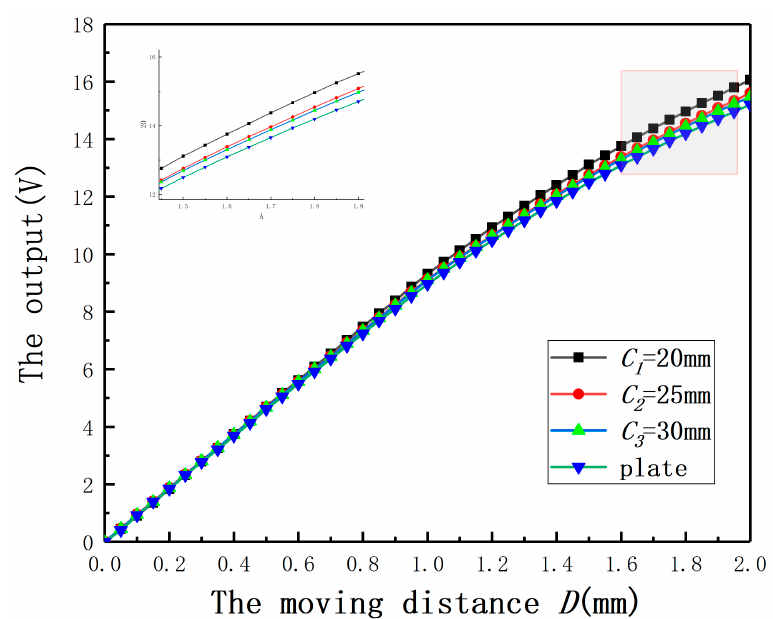
Figure 17. The relationship between the output and the moving distance under different radii.